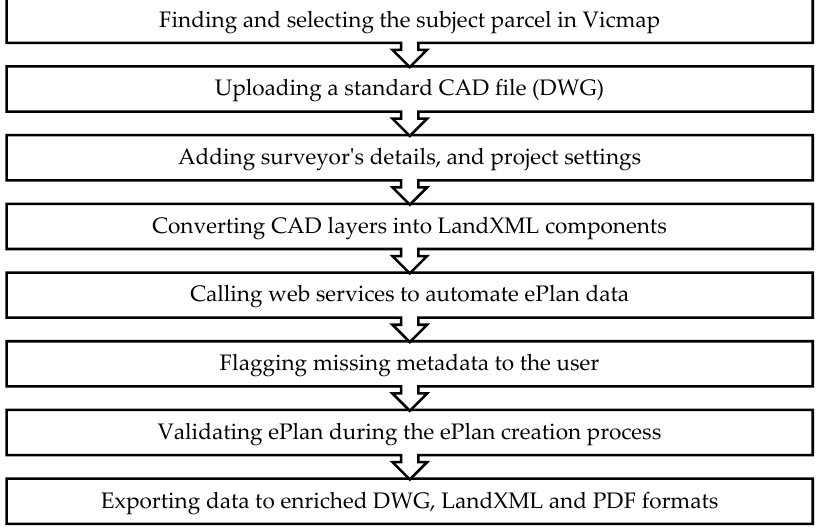
Figure 10. The ePlan creation workflow in the PoC.